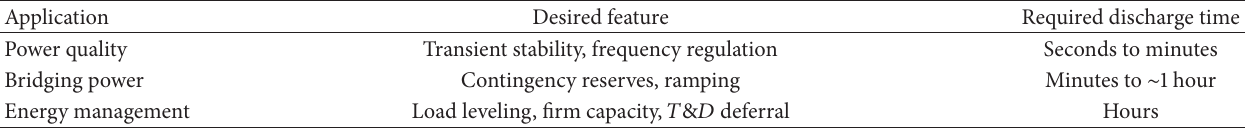
Table 3: Features of desired energy